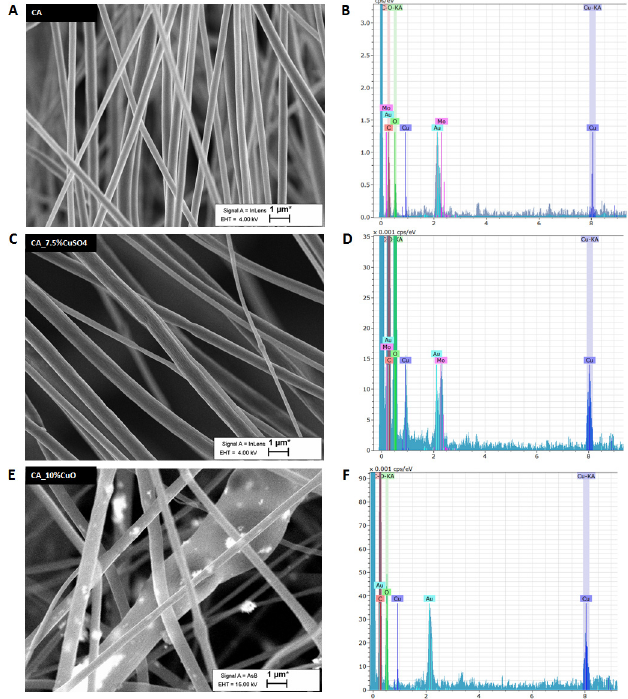
Figure 1. Morphological characteristics by SEM imaging for electrospun CA filter mats (panels A , C , E ) and EDX analysis of the mats (panels B , D , F ). Please refer to the different scales on the y -axis.